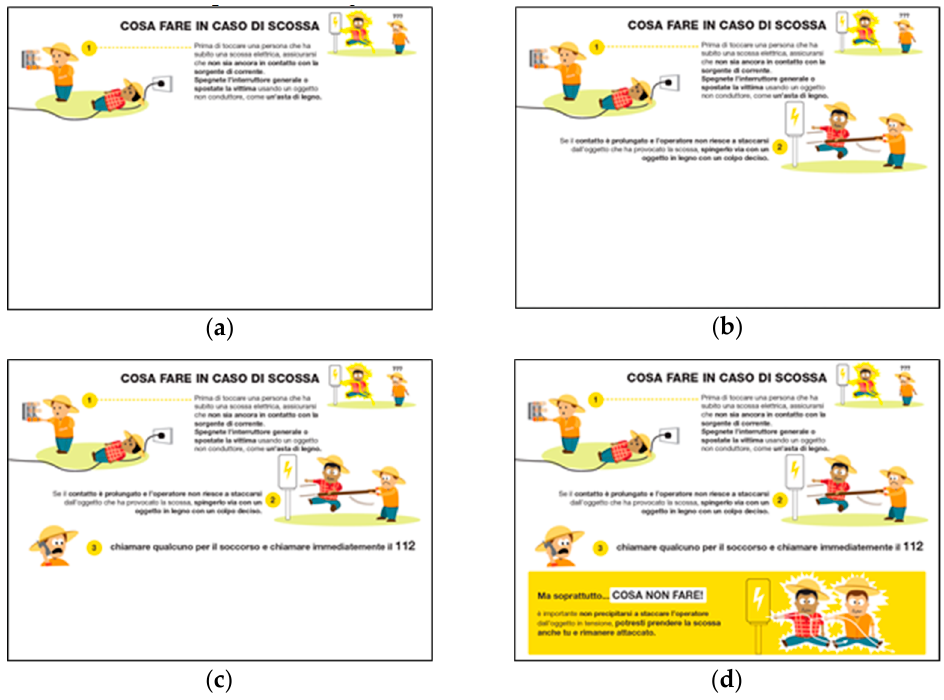
Figure 2. Slides about “what to do in case of electrical shock” shown to migrant farmworkers: a basic animation was added to the slide to explain the correct behaviour to be performed in four different steps: ( a ) turn off the flow of electricity; ( b ) remove the wire or the electrocuting appliance or source with a wooden stick; ( c ) call local emergency; ( d ) do not touch someone who has been shocked if they are still in contact with the source of electricity.